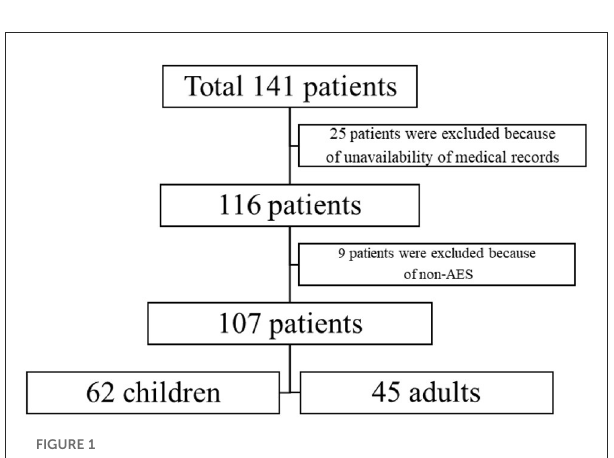
FIGURE1 Flowchart of patient